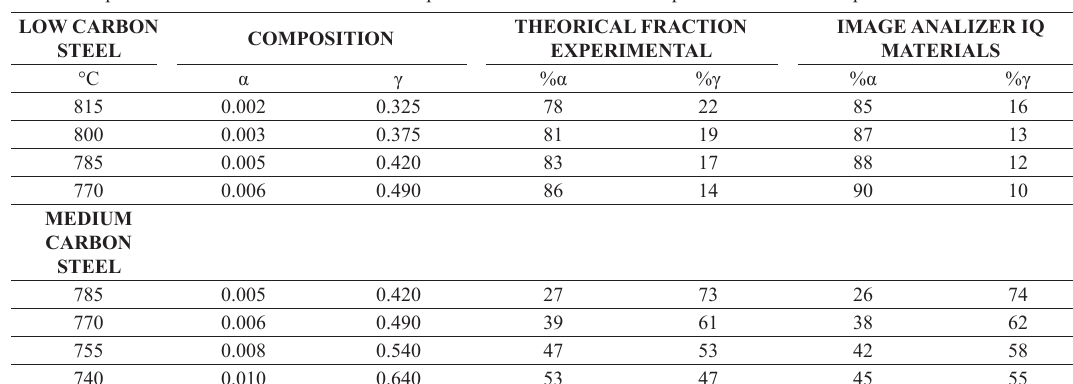
Table 4. Experimental and theoretical values of the phases and their chemical composition at the test